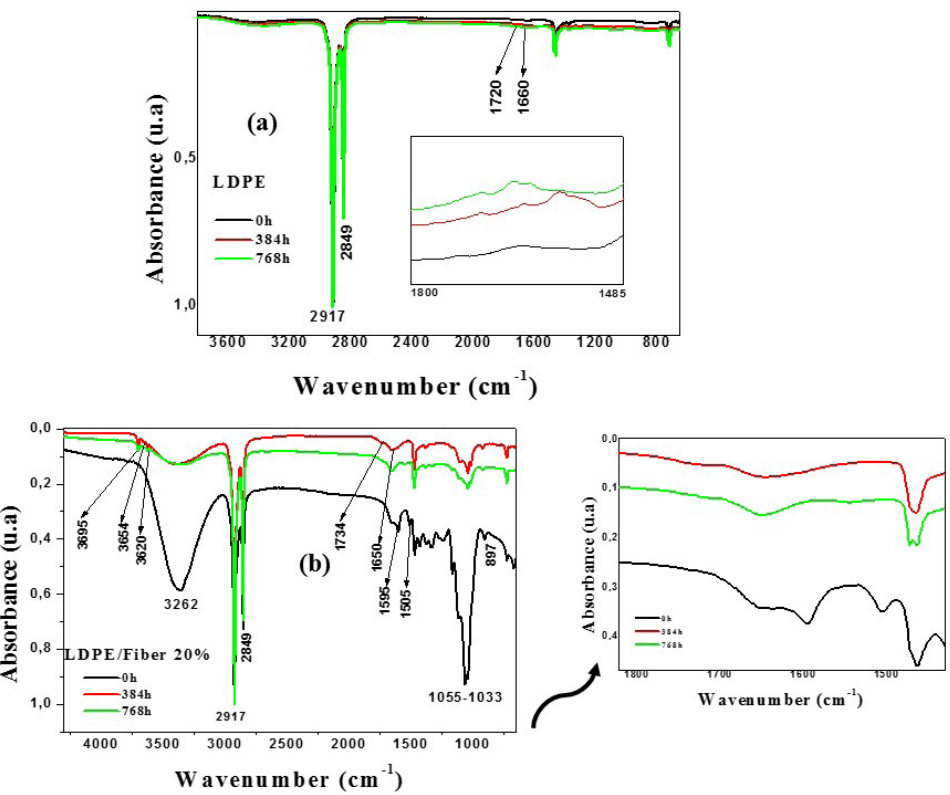
Figure 6. FTIR spectrum of pure LDPE matrix (a) different times of degradation by sunlight and (b) 20% fiber at different times of degradation by